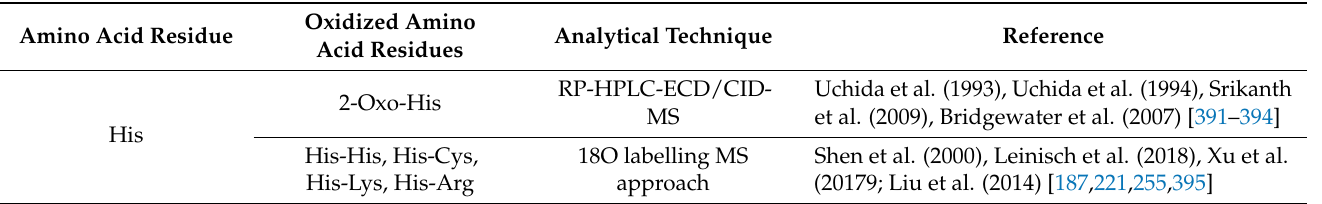
Figure 6. Chemical structures of Histidine and common Histidine photo-oxidation products such as 2-Oxo-His and His-His crosslink. Table 10. Analytical techniques/assays to detect His oxidation products with the corresponding analytical techniques and relevant references.